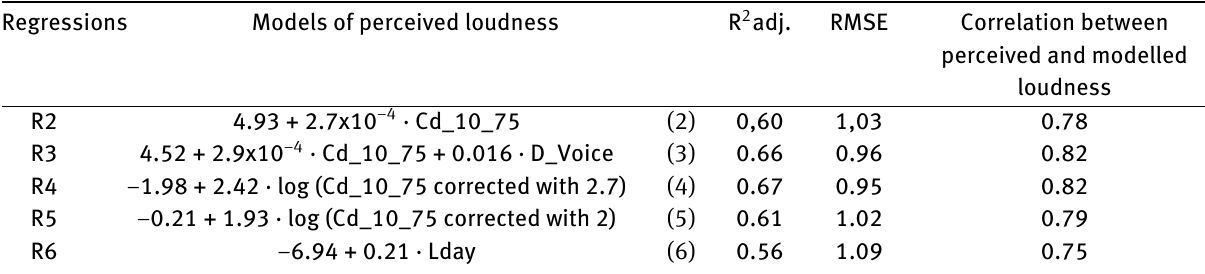
Table 3: Adjusted R-squared values, Root mean square errors and Correlations between perceived and modelled loudness for different linear regressions.